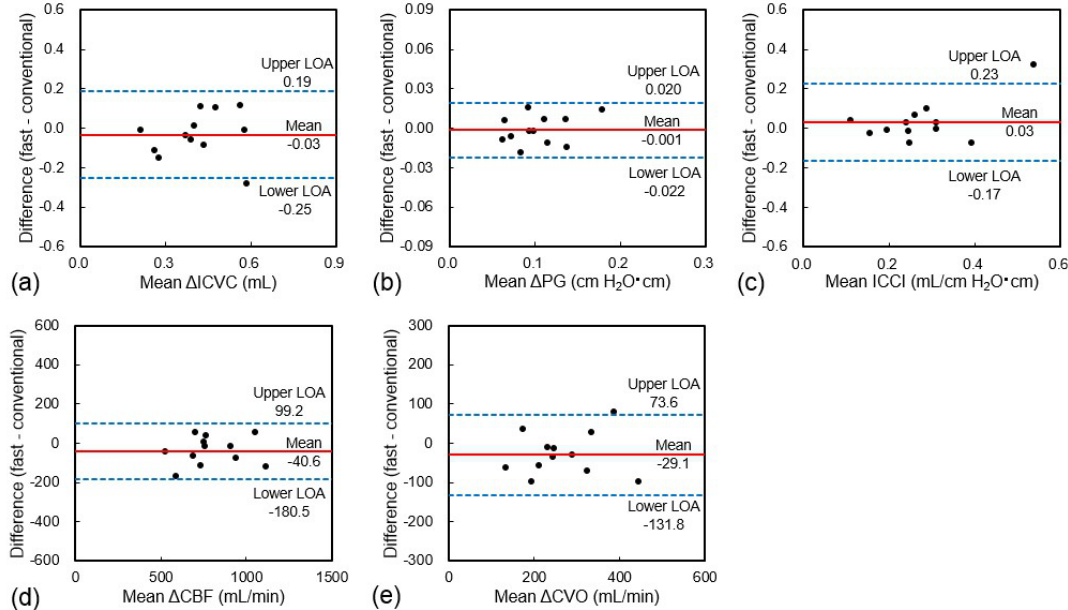
Figure 3. Bland–Altman plots showing differences in ( a ) ΔICVC, ( b ) ΔPG, ( c ) ICCI, ( d ) ΔCBF, and ( e ) ΔCVO during free breathing between proposed fast and conventional PC-cine MRI methods. Red solid line, mean difference; blue dashed lines, upper and lower limits of agreement (LOA, mean ± 2SD).